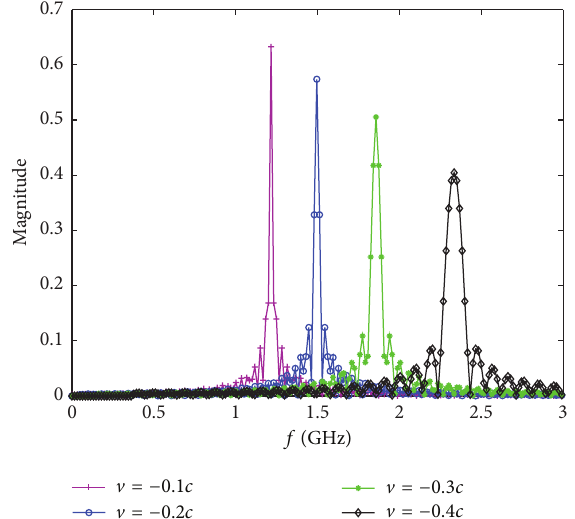
Figure 7: Frequencies of the scattered waves from the conducting surface moving along the −𝑧 -axis.